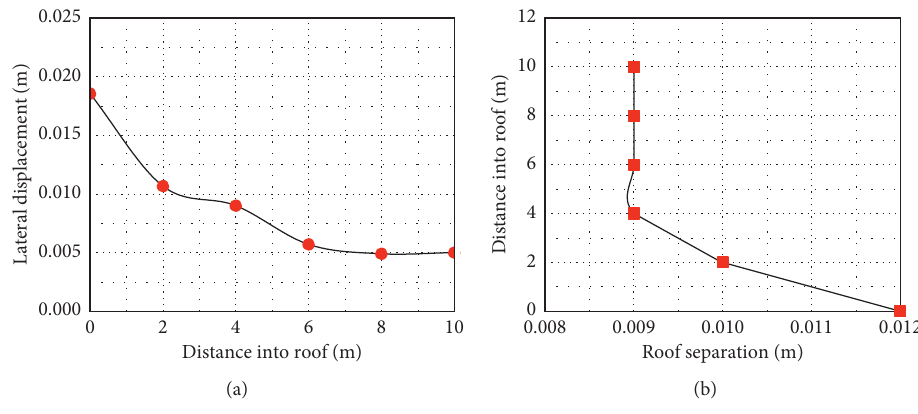
Figure 16: Chamber deformation: (a) lateral displacement and (b) roof